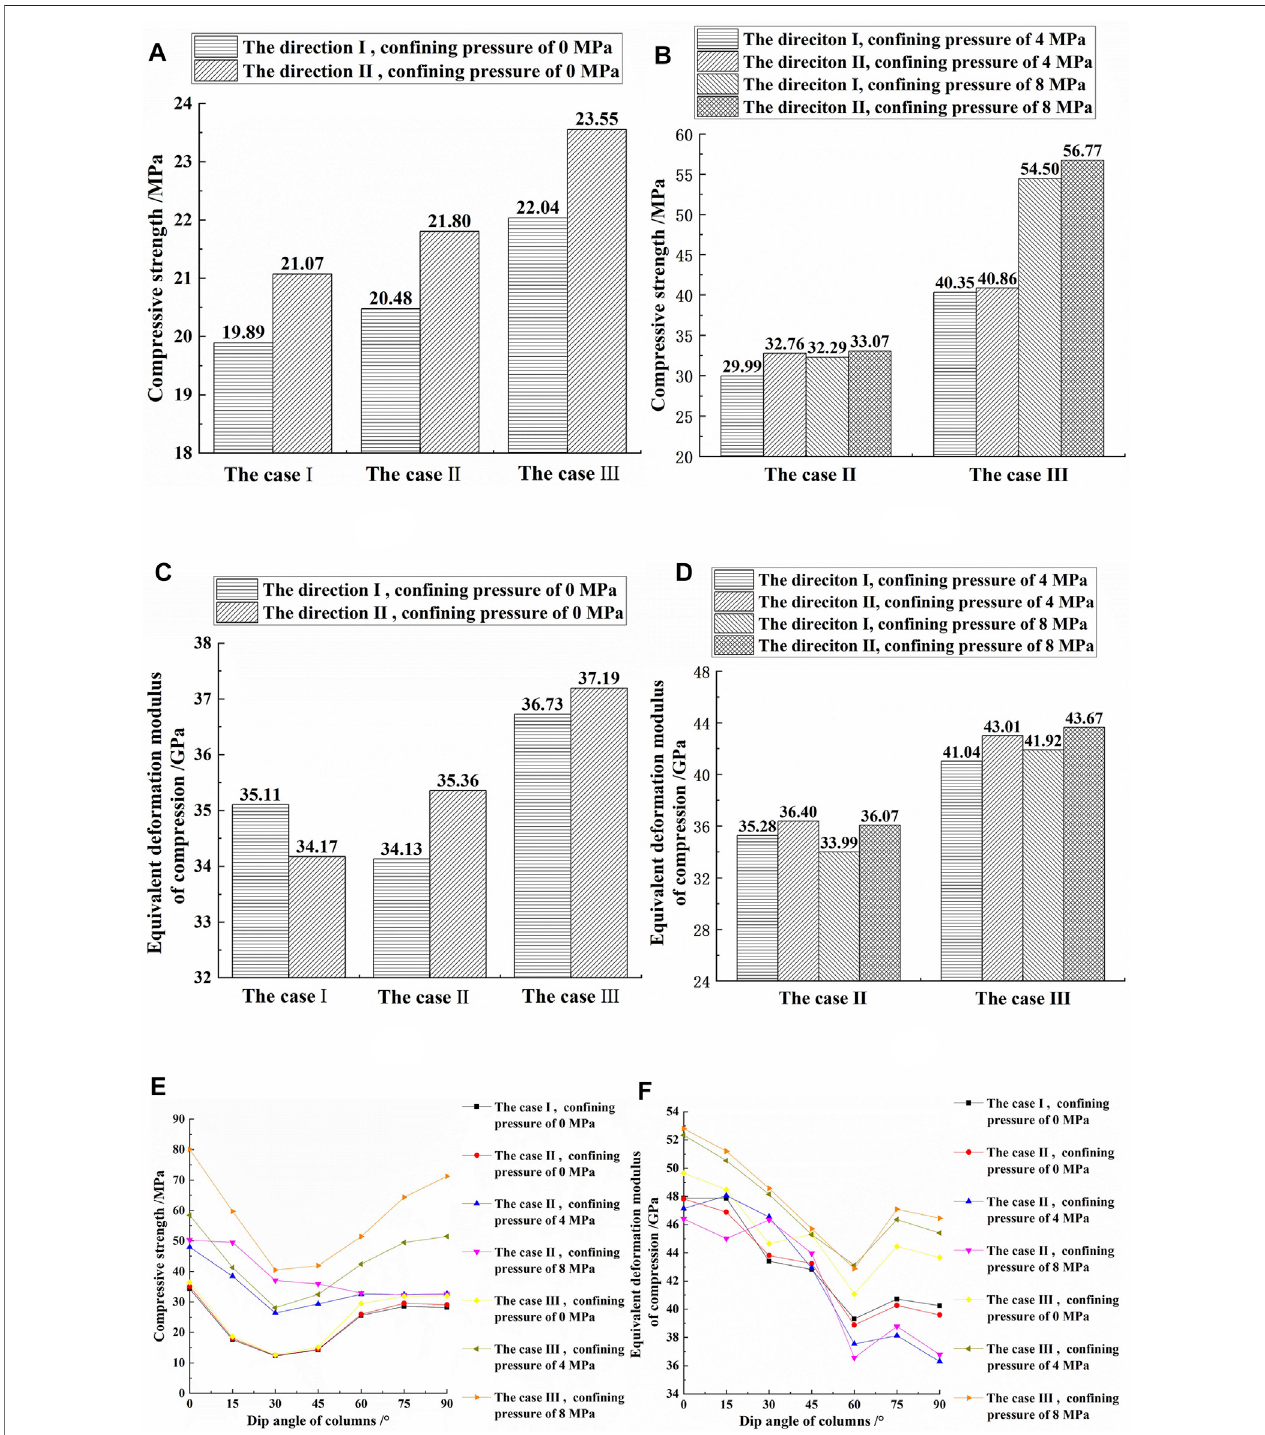
FIGURE 5 | (A,B) Strengths of columnar jointed basalts (CJBs) with different model boundaries and con fi ning pressures in the direction orthogonal to the column axis. (C,D) The equivalent deformation moduli of CJBs in the direction orthogonal to the column axis. (E,F) The strengths and equivalent deformation moduli of CJBs in thedirectionparalleltothecolumnaxis(caseI,caseII,andcaseIIIcorrespondtothecaseofplanestress,thecasebetweenplanestressandplanestrain,andthecaseof plane strain, respectively).